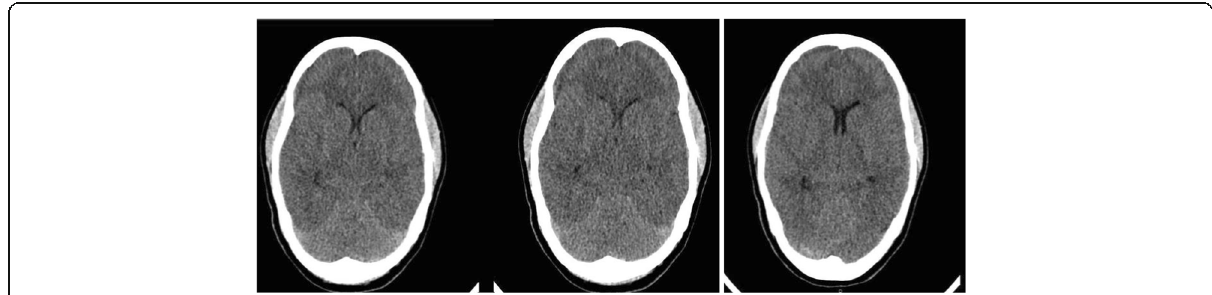
Fig. 2 Computerized axial tomography with diffuse cerebral edema, showing loss of differentiation between grey and white matter and compression of the